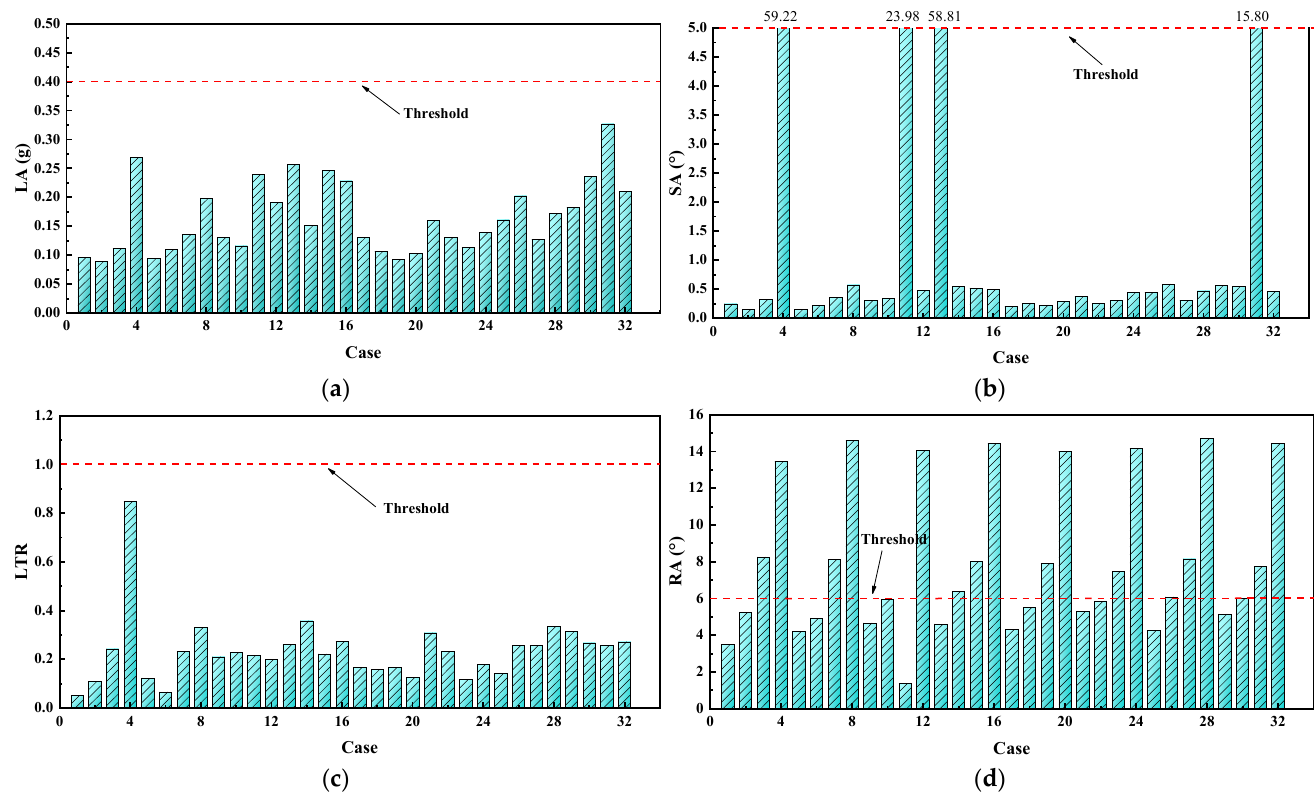
Figure 12. Driving stability indicator based on orthogonal simulation results: ( a ) LA; ( b ) SA; ( c ) LTR; ( d ) RA.